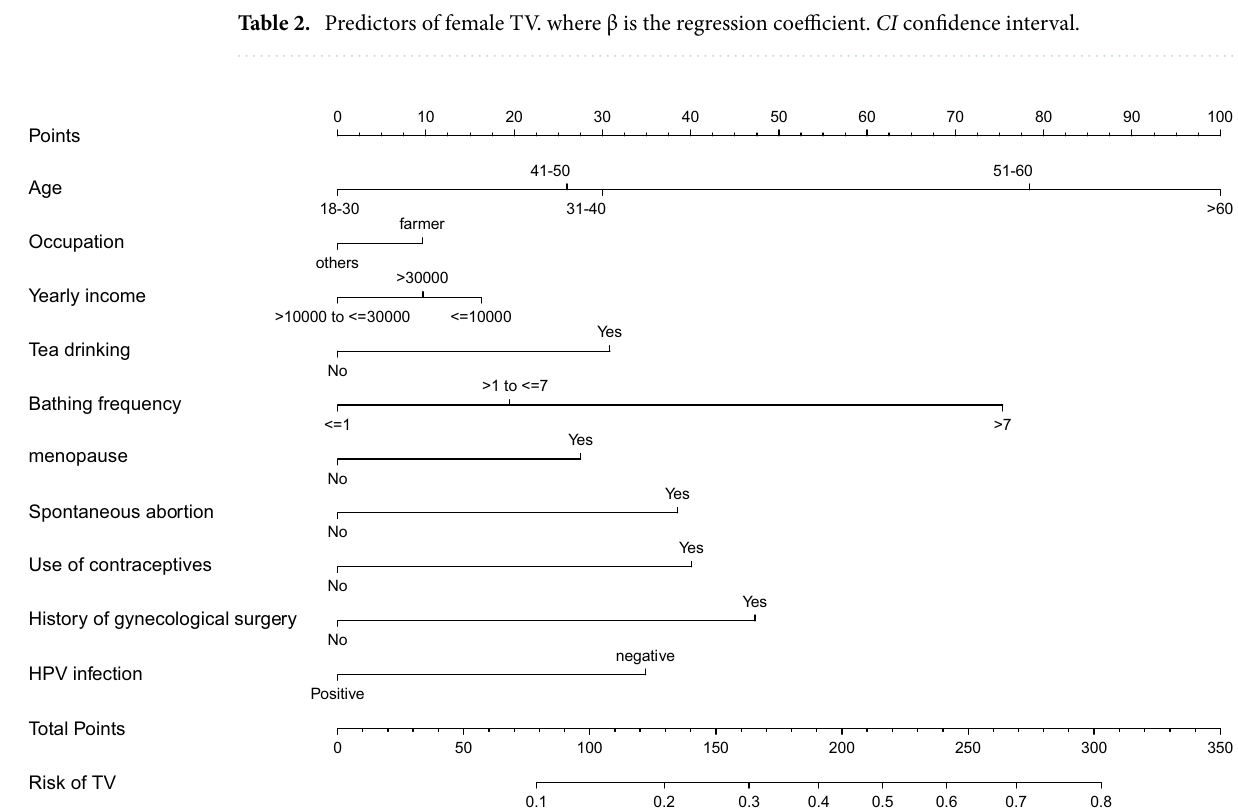
Figure 2. TV risk assessment tool. Points refers to point for the individual risk factor and add together to the total